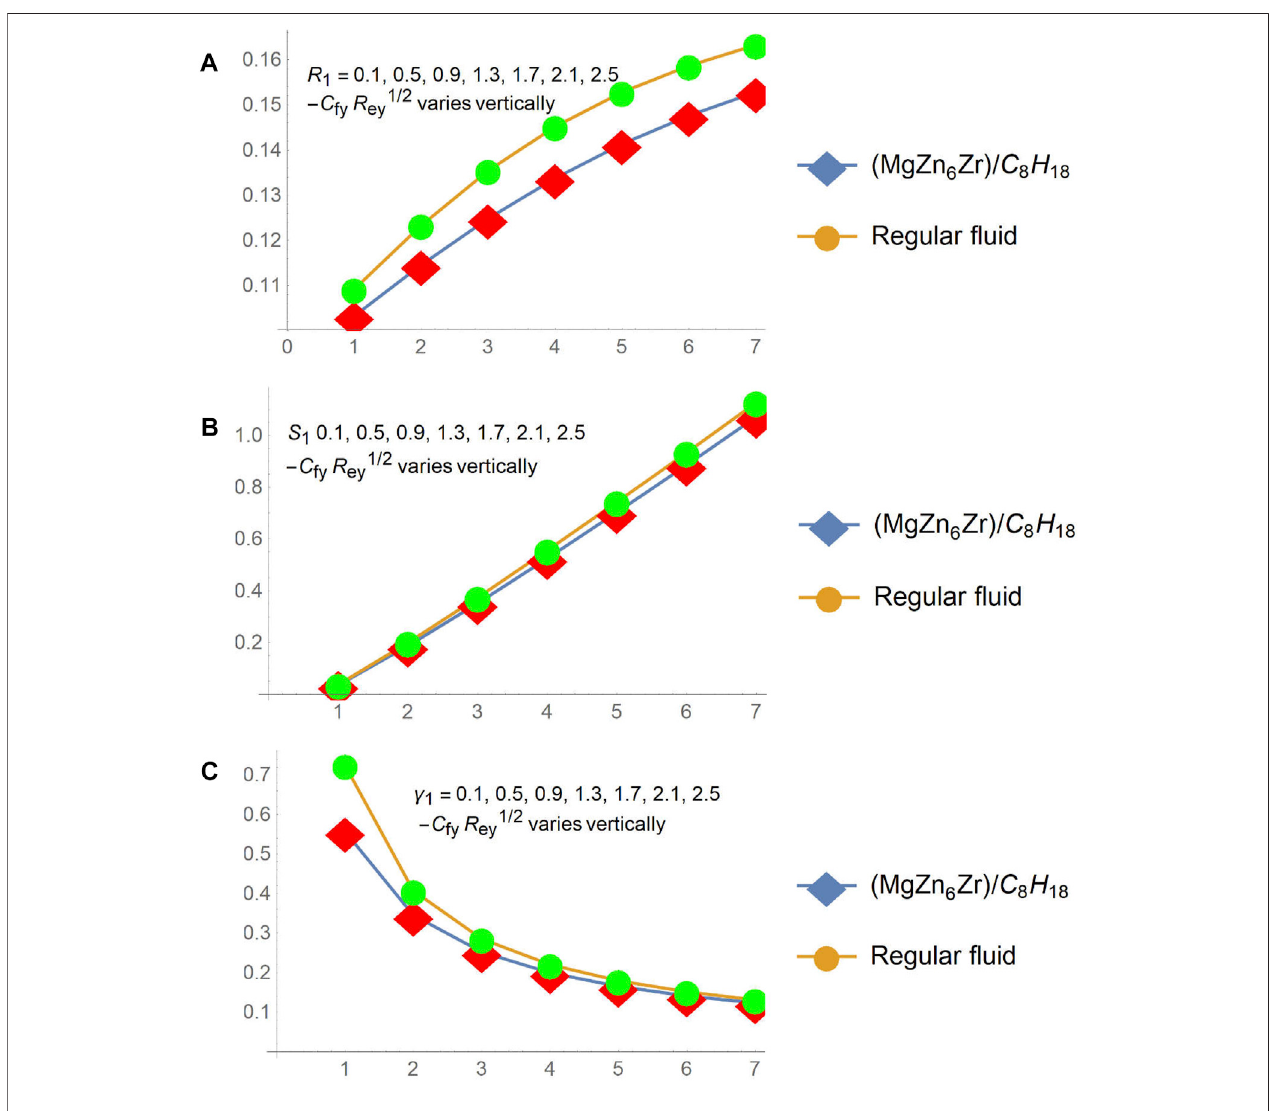
FIGURE 15 | Skin friction in y -direction via (A) R 1 (B) S t and (C) γ 1 .